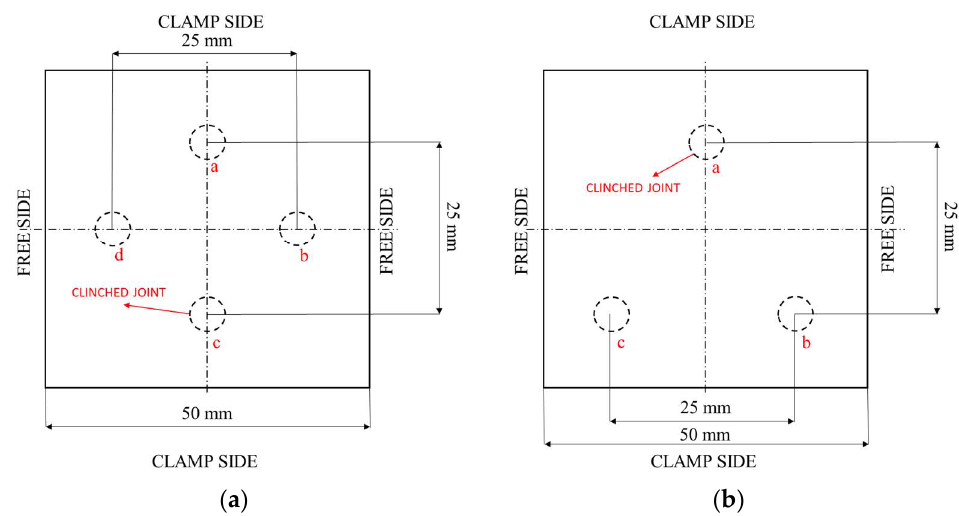
Figure 3. Overview on the tested configurations: ( a ) Configuration 1; ( b ) Configuration